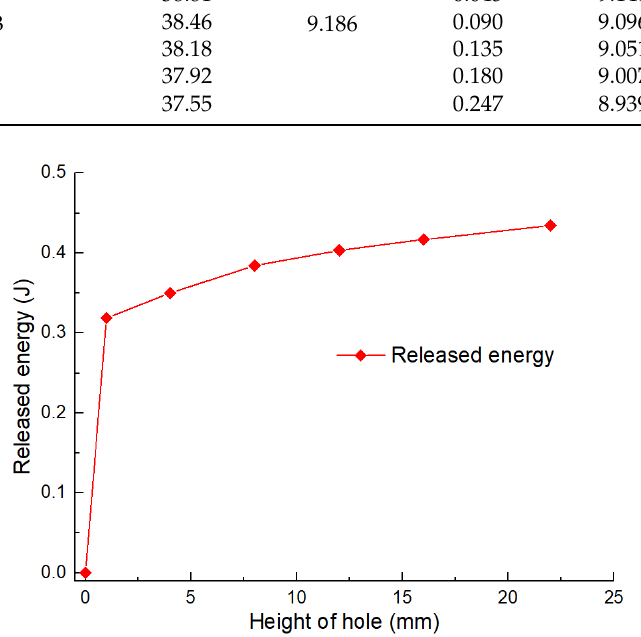
Figure 9. Strain energy release caused by different heights h of excavation holes.